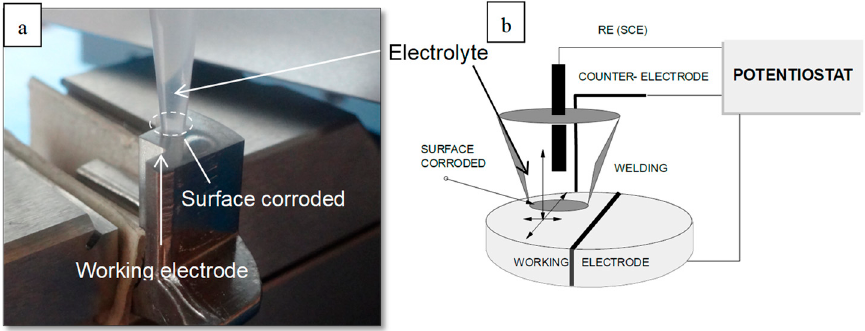
microelectrode technique. The schematic representation of the microelectrode technique is illustrated in Figure 3.